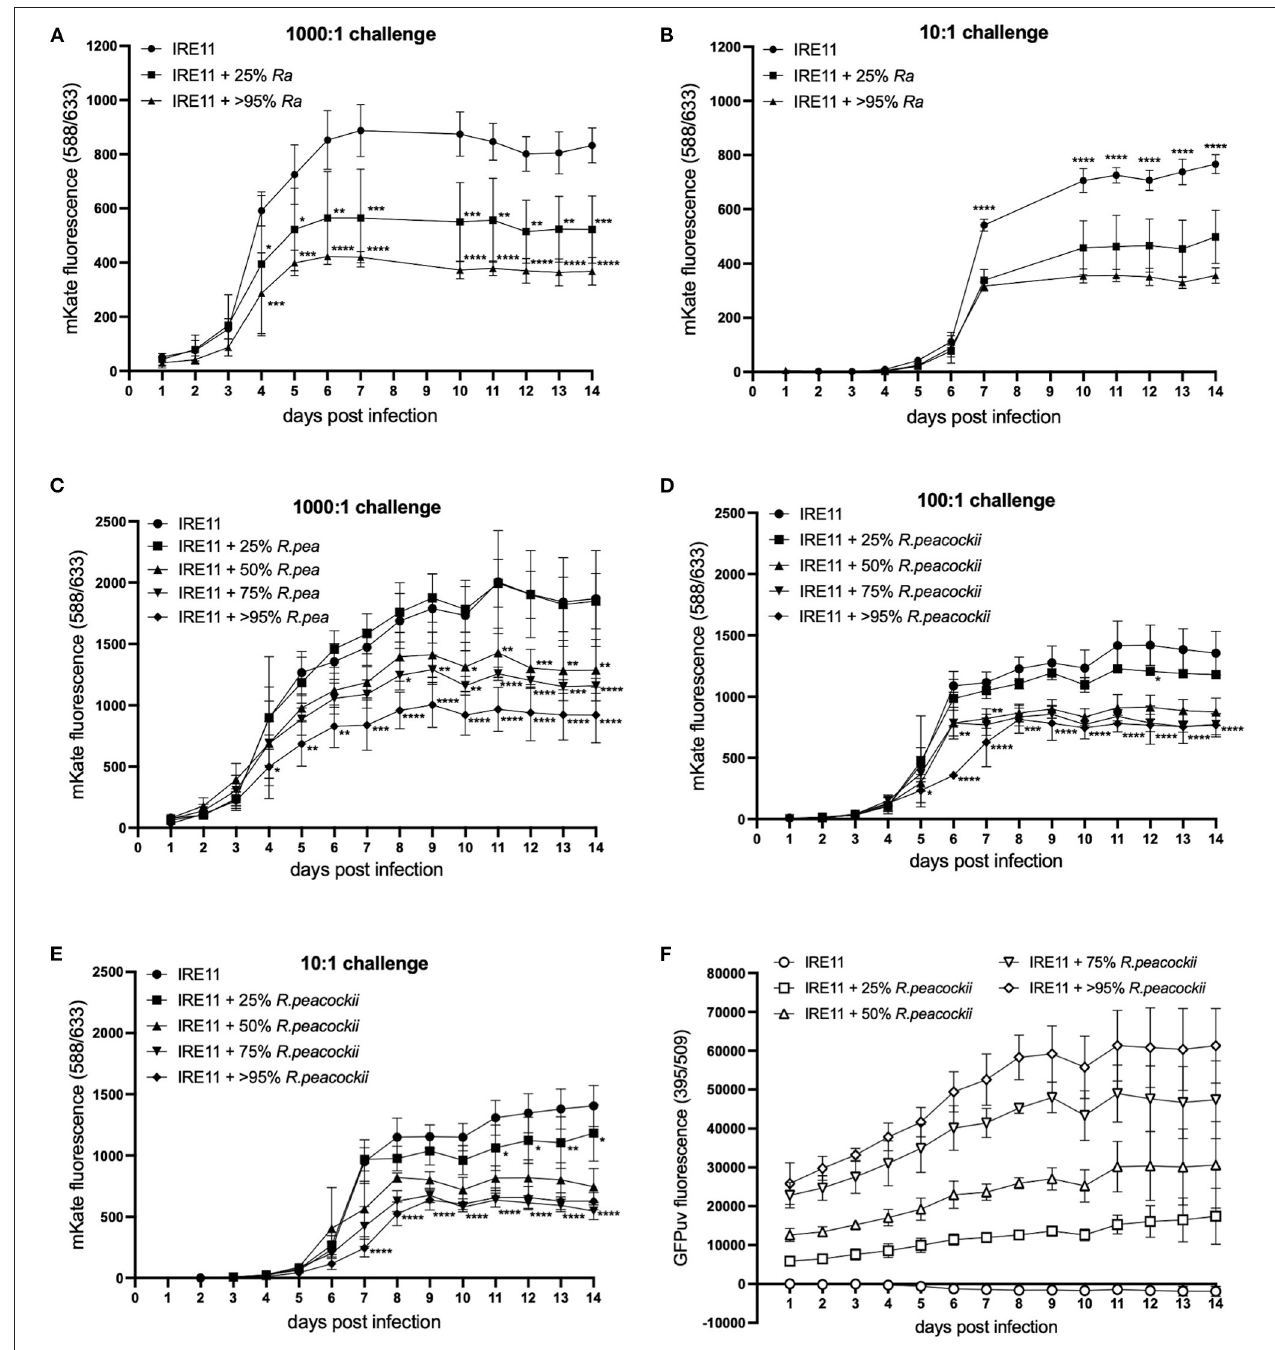
FIGURE 6 | Rickettsia parkeri replication in the presence of R. amblyommatis or R. peacockii. Replication of R. parkeri -mKate in tick cells was monitored for 14 days by measuring mKate fluorescence on a microplate reader. (A,B) R. parkeri- mKate replication in IRE11 cells with or without R. amblyommatis at 28 ◦ C in a candle jar at challenge doses of 1,000:1 (A) and 10:1 (B) ; readings not taken on day 8 or 9. (C–E) R. parkeri- mKate replication in IRE11 cells with or without R. peacockii- GFPuv at 28 ◦ C in a candle jar at challenge doses of 1,000:1 (C) , 100:1 (D) , and 10:1 (E) . (F) GFPuv fluorescence indicating replication of R. peacockii- GFPuv. Data show mean and error bars standard deviation of three replicate wells. Means were compared to the uninfected control IRE11 using a two-way ANOVA with Dunnett’s multiple-comparison test; statistically significant values are marked by asterisks * p < 0.05, ** p < 0.01, *** p < 0.001, **** p < 0.0001. Data are representative of two independent experiments (see Supplementary Figure S4